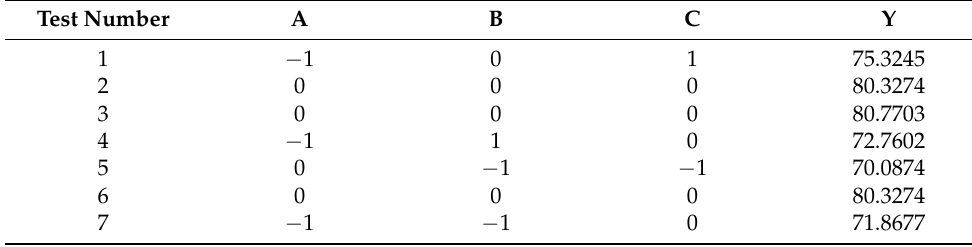
Table 3. Response surface optimisation test